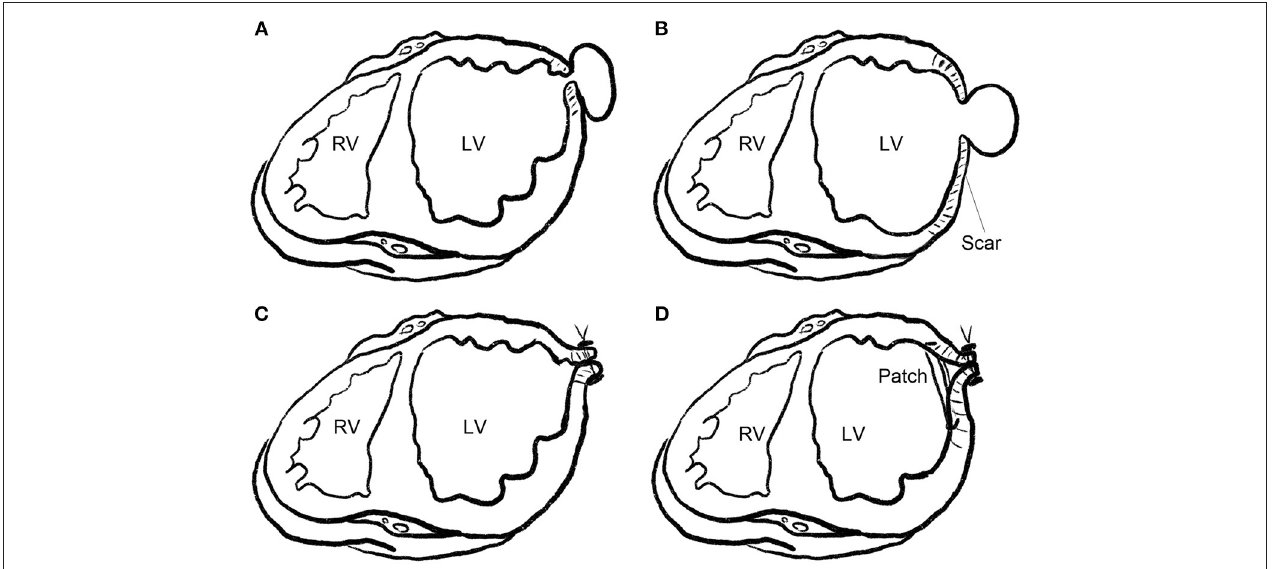
FIGURE 1 | Repair technique for LV pseudoaneurysm. (A) Pseudoaneurysm with a narrow neck. (B) Pseudoaneurysm with a wide neck or extensive scarring around the neck (pseudoaneurysm superimposed on a true aneurysm). (C) Pseudoaneurysm with a narrow neck, as shown in (A) , was closed linearly with continuous or horizontal mattress sutures with pledgets. (D) Pseudoaneurysm with a wide neck and extensive scaring around the neck, as shown in (B) , was closed with a patch, and the scarred wall was trimmed and sutured over the patch.